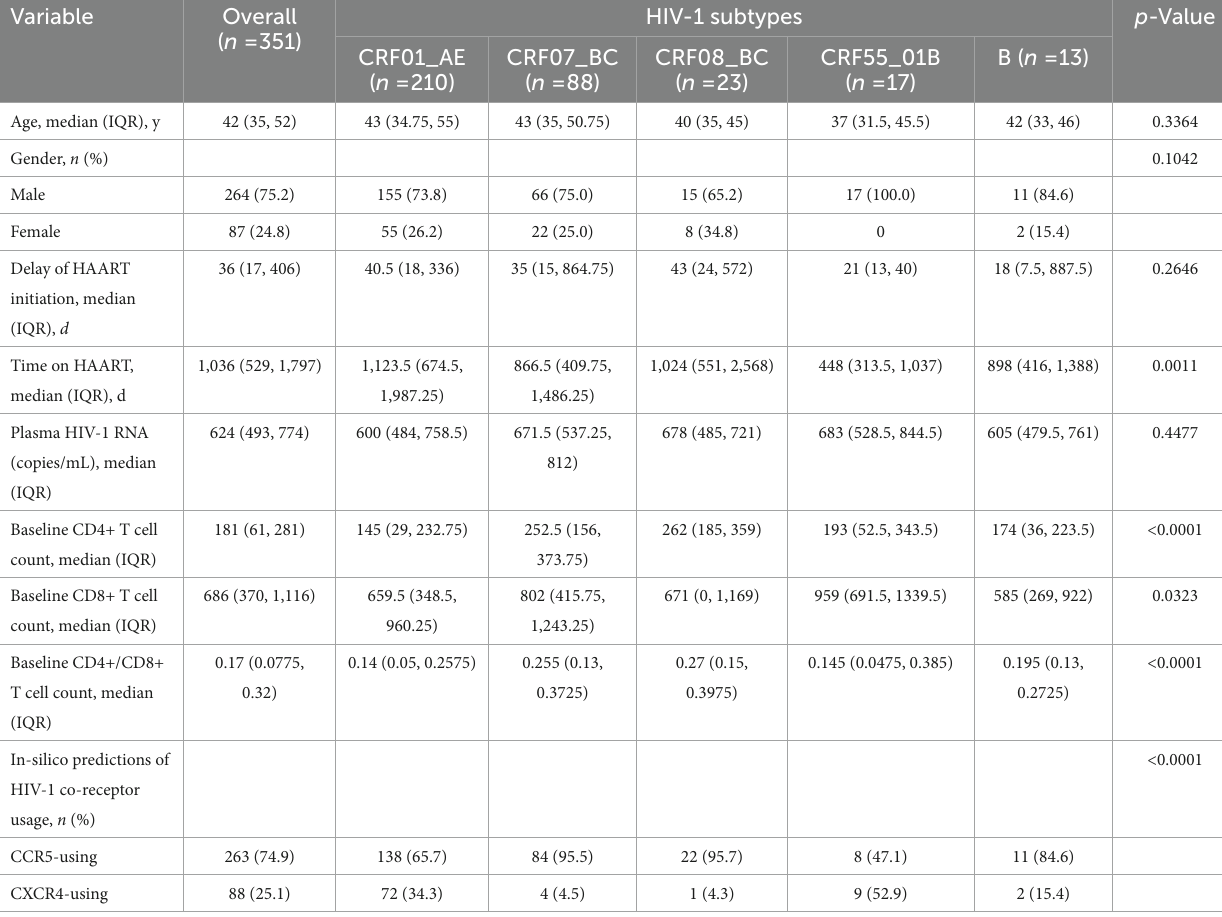
TABLE 1 Demographics and characteristics of the cases with baseline CD4 + T cell count ( N = 351).